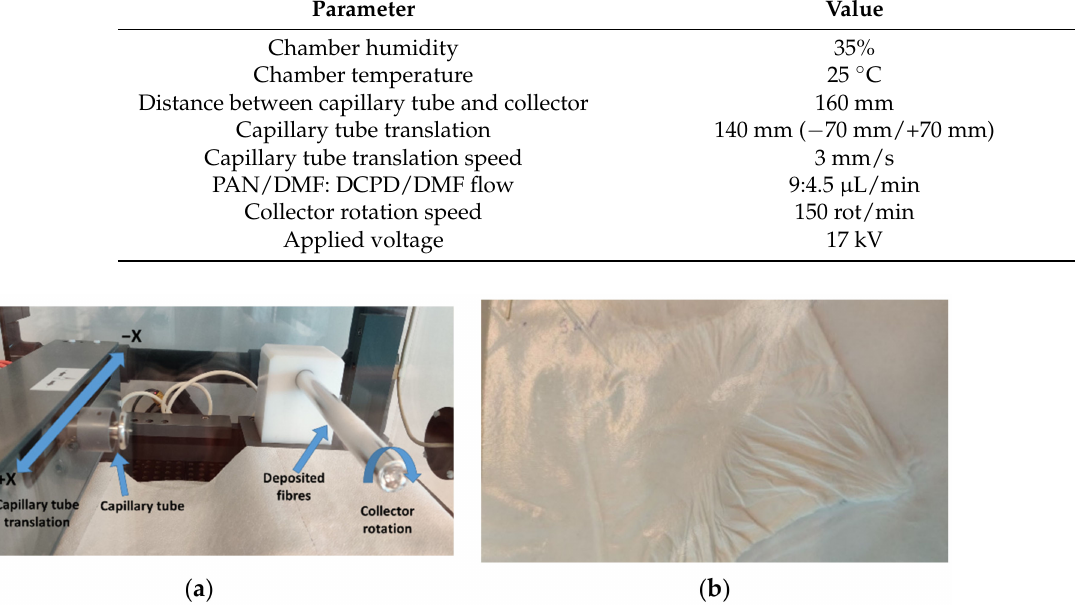
Figure 2. Images ( a ) during electrospinning process and of ( b ) synthesised microvascular network